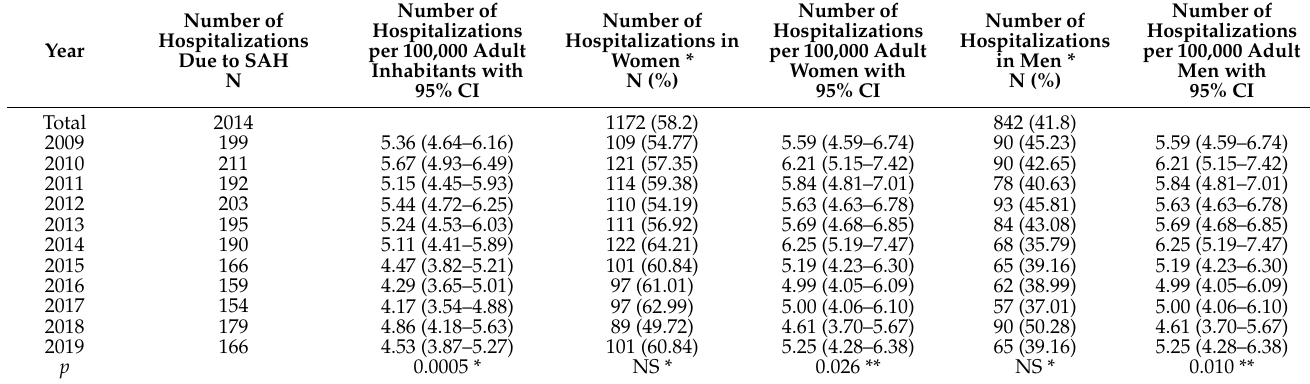
Table 1. The number of hospitalizations due to SAH (I60) in the Silesian Province between 2009 and 2019.